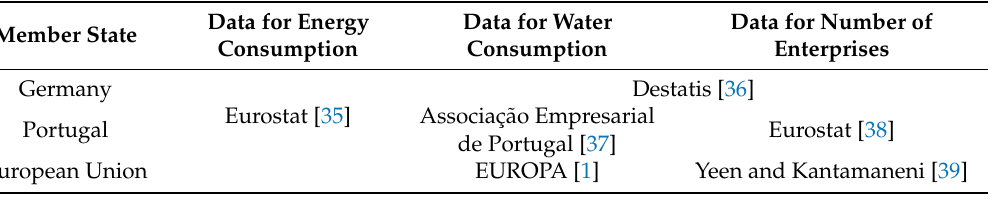
Table 3. Sources for energy and water consumption.